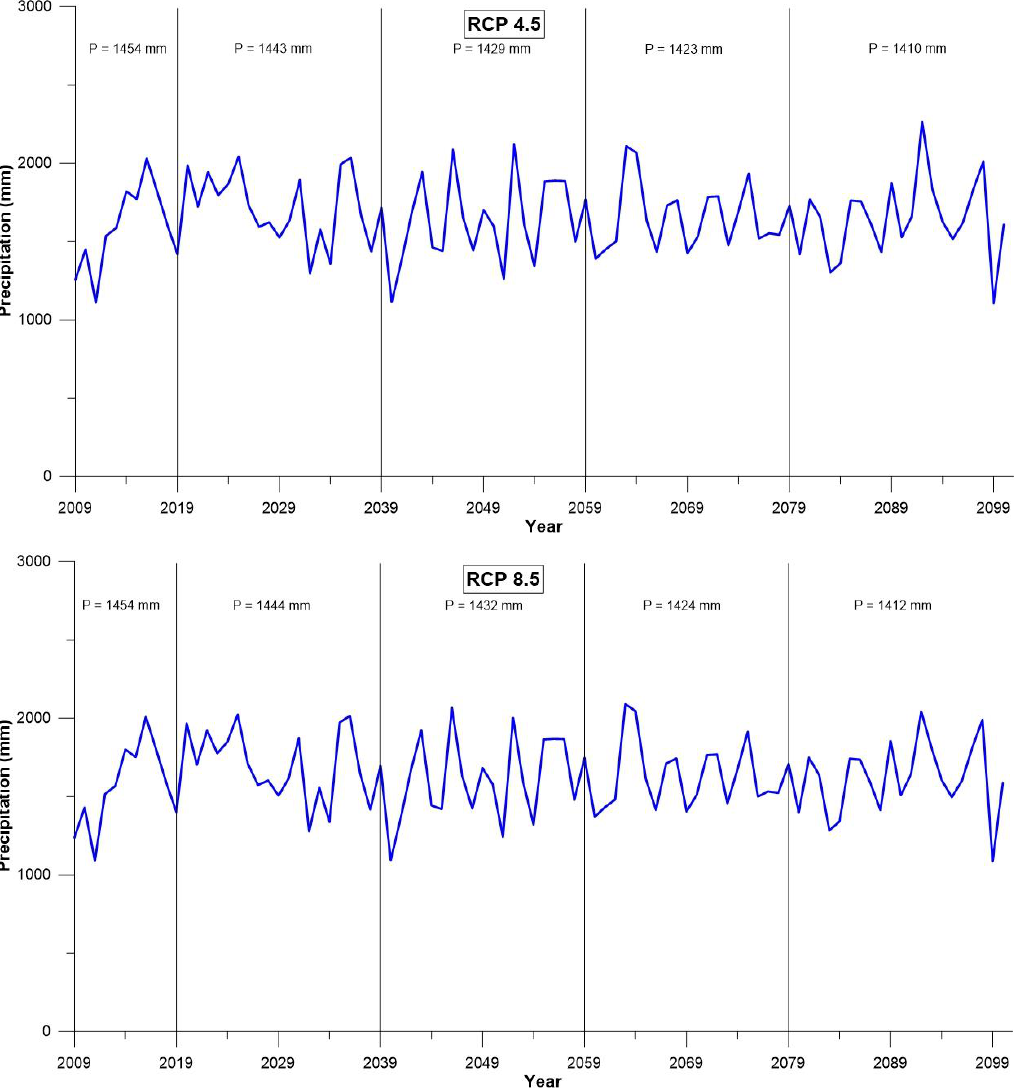
Figure 4. Predicted precipitation of 2009 to 2100 by the RCP 4.5 and 8.5 climate scenarios in the Nakdong River watershed.